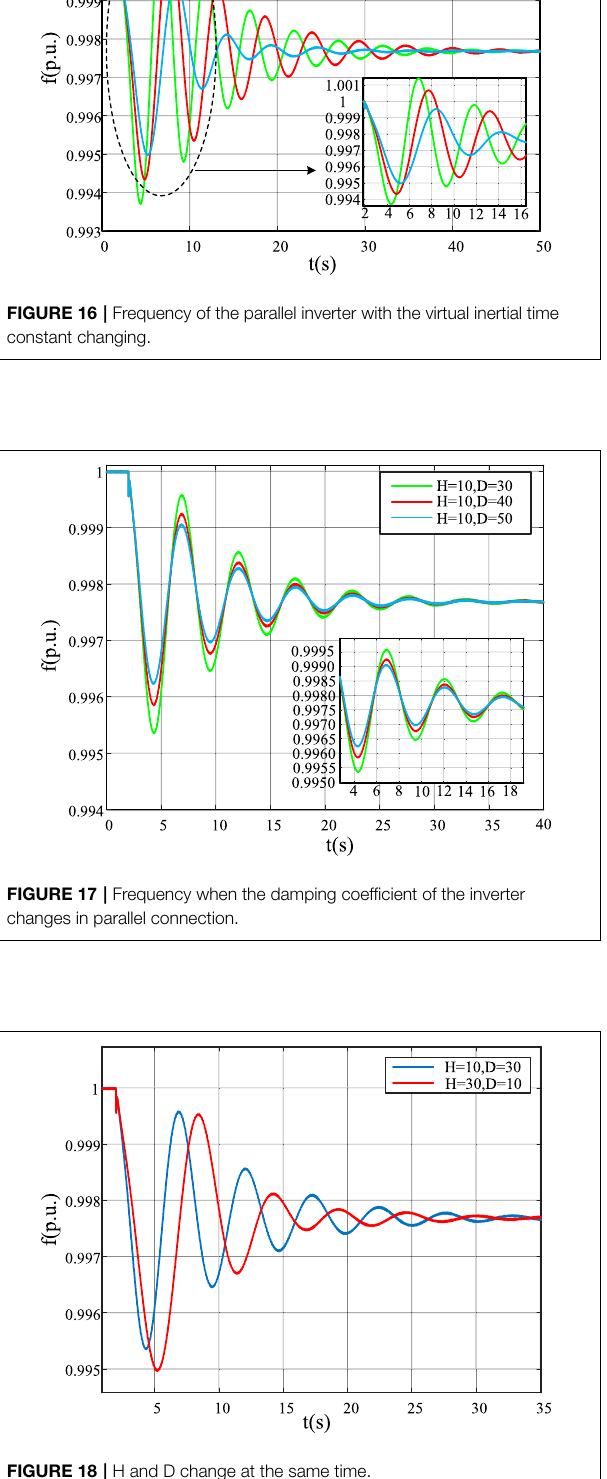
FIGURE 18 | H and D change at the same